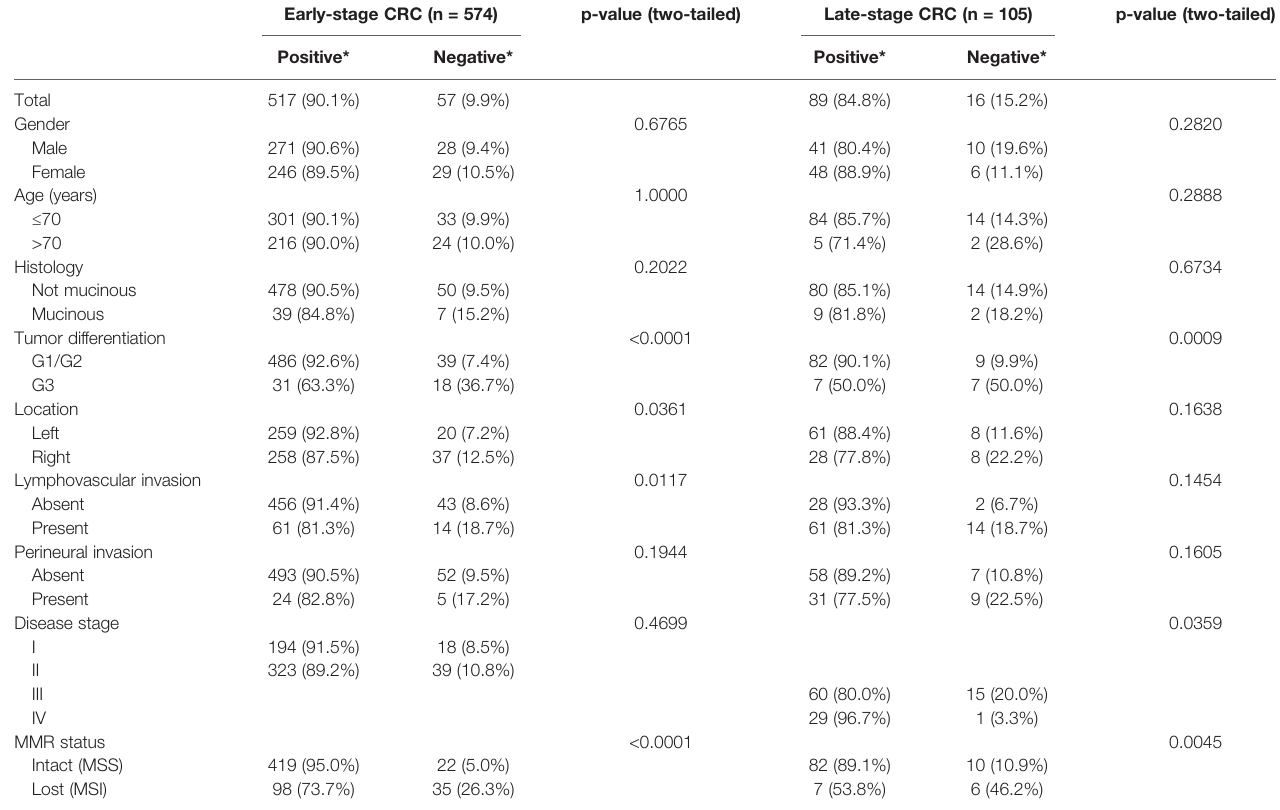
TABLE 1 | GALNT6 protein expression vs. clinical features of colorectal cancer